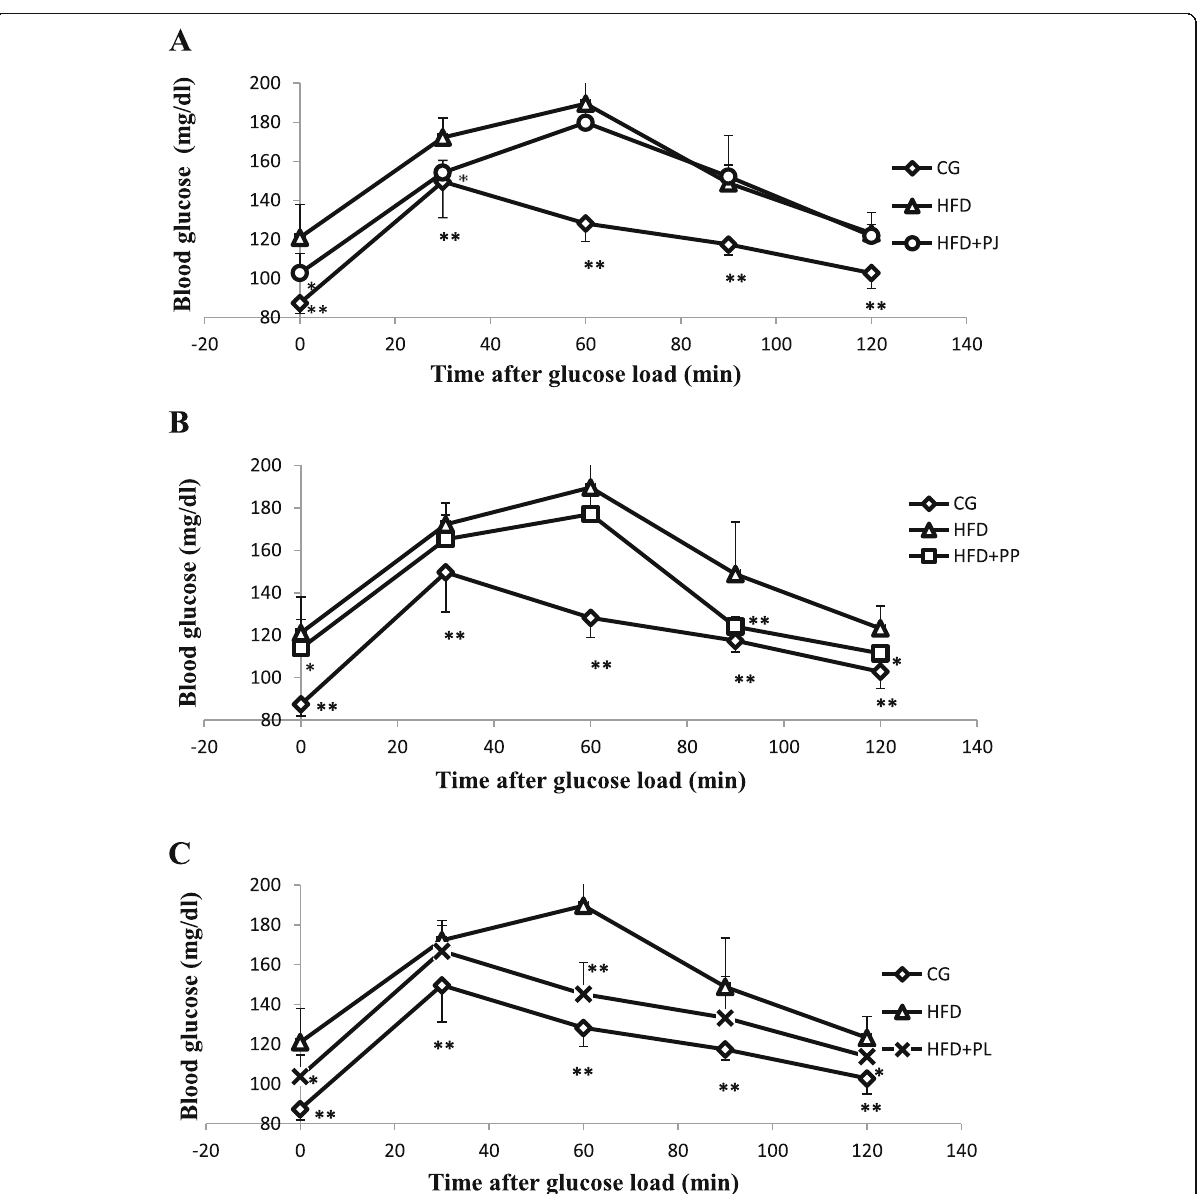
Fig. 1 Effect of pomegranate extracts supplementation on glucose tolerance curve in rats during 11 weeks experimental period. Results are shown as the mean ± SE ( n = 6). * p < 0.05; ** p < 0.01 versus HFD group, pomegranate juice ( a ), pomegranate peel ( b ) and pomegranate leaves ( c